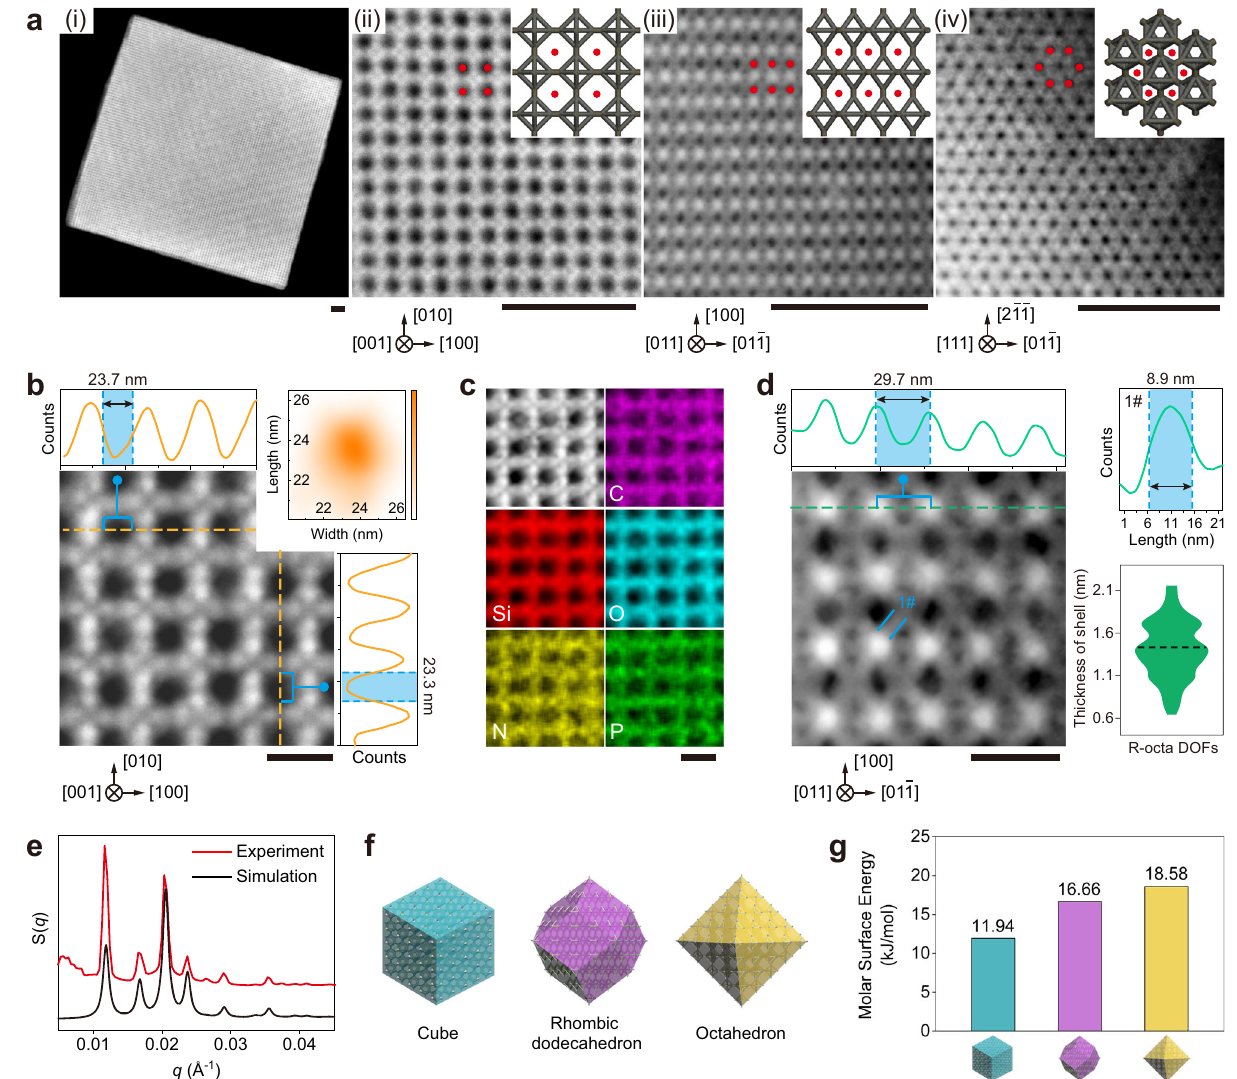
Fig. 3 Determination of the structure and internal uniformity of cubic microcrystals. a HAADF-STEM image of a free-standing cubic microcrystal (i); close-up views of multiple facets (ii – iv) obtained by observation along different orientations, with models inserted in the top right panels. Scale bars: 250 nm. b Enlarged image of an arbitrary partial region of a (ii). Top and right panels: size measurements of external pores by line pro fi le analysis. Top right panel: size distribution of external pores. Scale bar: 50 nm. c HR-EDS mapping of the porous structure. C, Si, O, N, and P were determined and are labelled in purple, red, cyan, yellow and green, respectively. Scale bar: 50 nm. d Enlarged image of an arbitrary partial region of a (iii), with length (top) and width (top right) measurements of silici fi ed bundles by line pro fi le analysis, and thickness distribution of the silica shell (bottom right). Scale bar: 50 nm. e Representative one-dimensional SAXS result (red curve) and fi tting (black curve) of encapsulated cubic crystals. f Schematics of different shape Wulff polyhedra exposing different facets composed of R-octa DOFs. g Comparison of molar surface energies of exposed surfaces among different Wulff shapes. Source data are provided as a Source Data fi